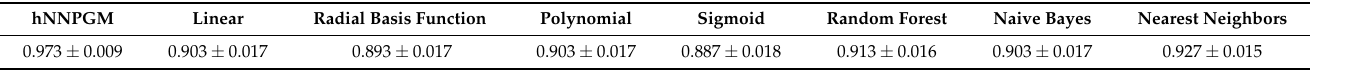
Table 1. Classification comparison, in terms of test average accuracy for 10 runs, for Iris dataset with hNNPGM hyperparameters k = 10 and h =